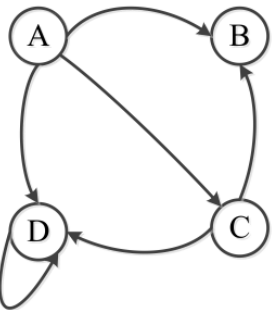
Figure 3. Example of a User Trust Network.